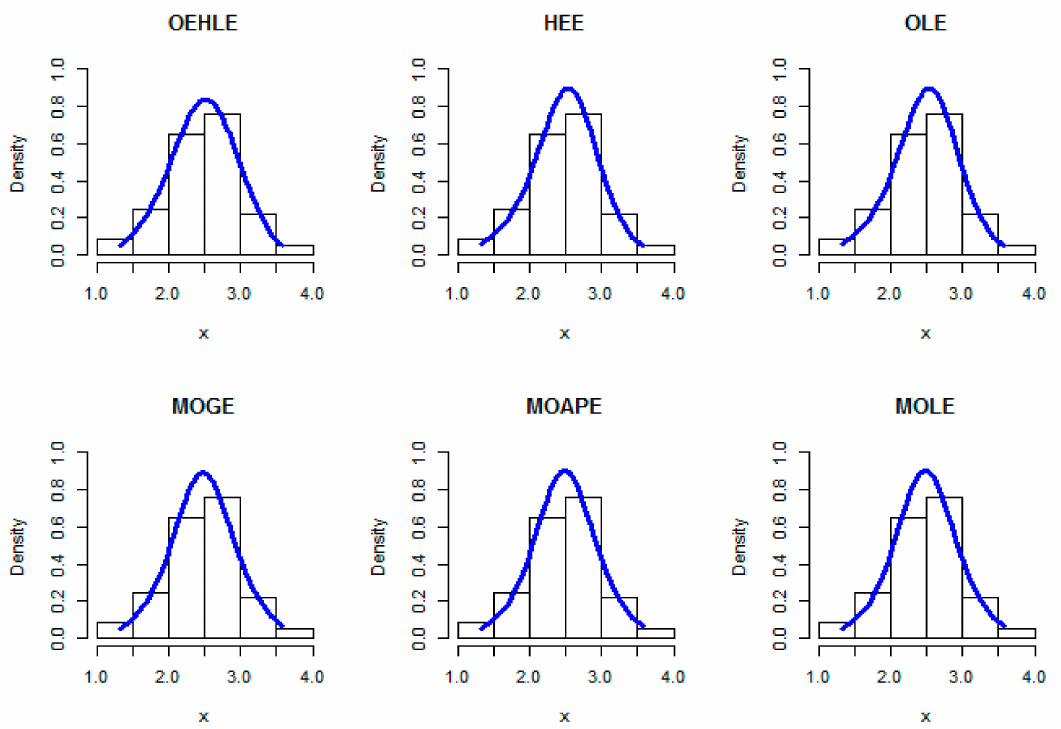
Figure 4. The fitted densities of the OEHLE model and the best five competing models for gauge lengths data.